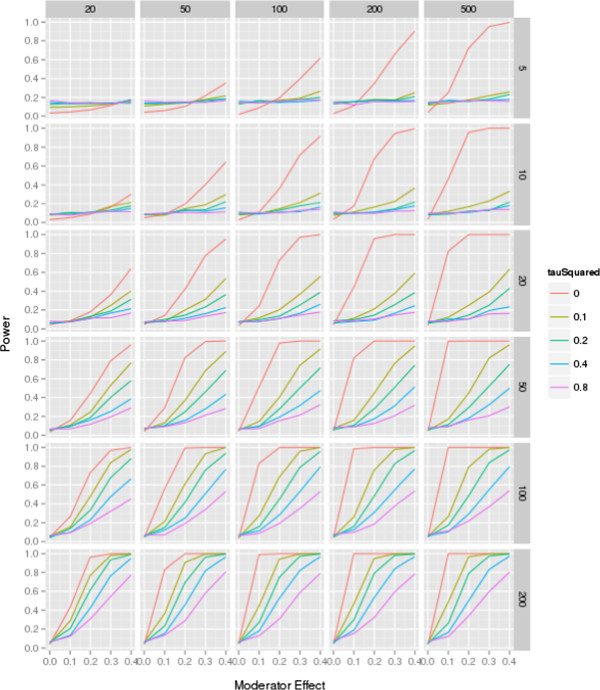
Power simulation, moderator distribution 25:75 ratio. The figure shows the power for each of the combination (number of studies in each meta-analysis ranging from 5 to 200 controlled trials; study sample size ranging from 20 to 500 participants; moderator effect ranging from 0 to 0.4; residual heterogeneity ranging from τ2 = 0 to 0.8; for a 25:75 distribution of the moderator (for example, 25% ‘high quality’, 75% ‘low quality’).